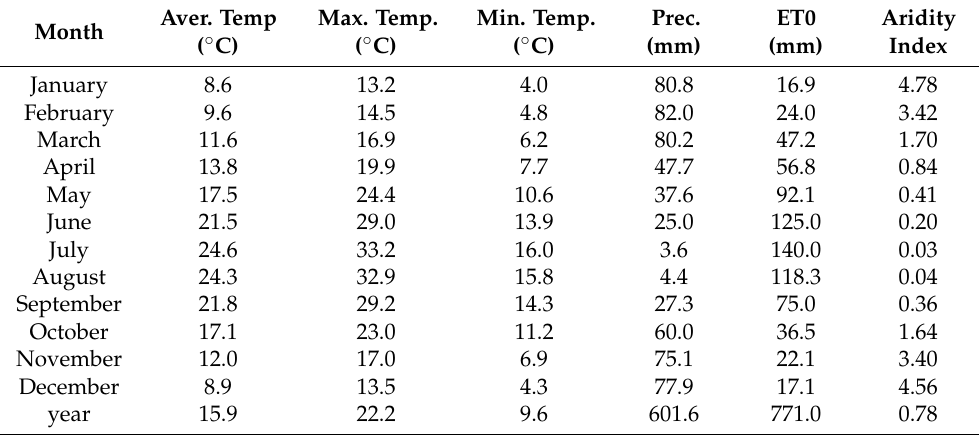
Table 1. Climate normal 1951/1980 [40].